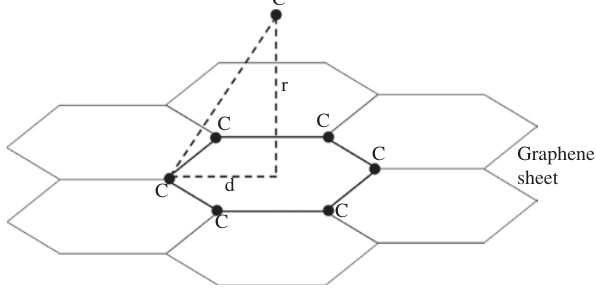
Figure 1: Carbon physisorption on GS at the most stable position with six nearest neighbor carbon atoms.